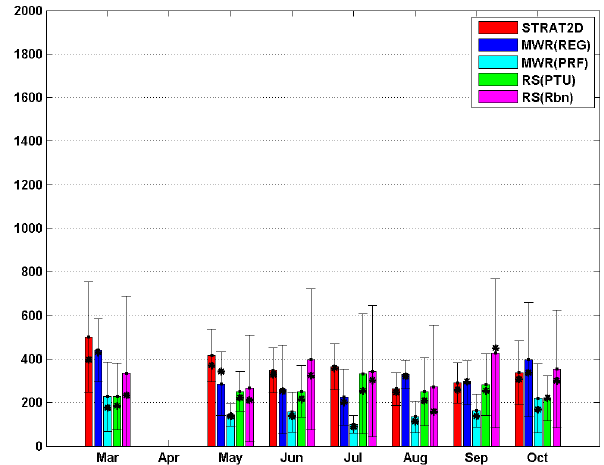
Fig. 6. Monthly mean average of diurnal MLH (ma.g.l.) as esti- Figure 6: Monthly mean average of diurnal MLH (m AGL) as estimated by STRAT2D (red), 3 mated by STRAT2D (red), MWR Tb regression (blue), MWR pro- MWR Tb regression (blue), MWR profiles (cyan), radiosonde PTU (green), and radiosonde 4 files (cyan), radiosonde PTU (green), and radiosonde Rbn (ma- Rbn (magenta). Black stars and error bars indicate the median value and one standard 5 genta). Black stars and error bars indicate the median value and one standard deviation, respectively. Values are taken as 1h average deviation, respectively. Values are taken as 1-hour average around 11.30 UTC. 6 around 11:30UTC.